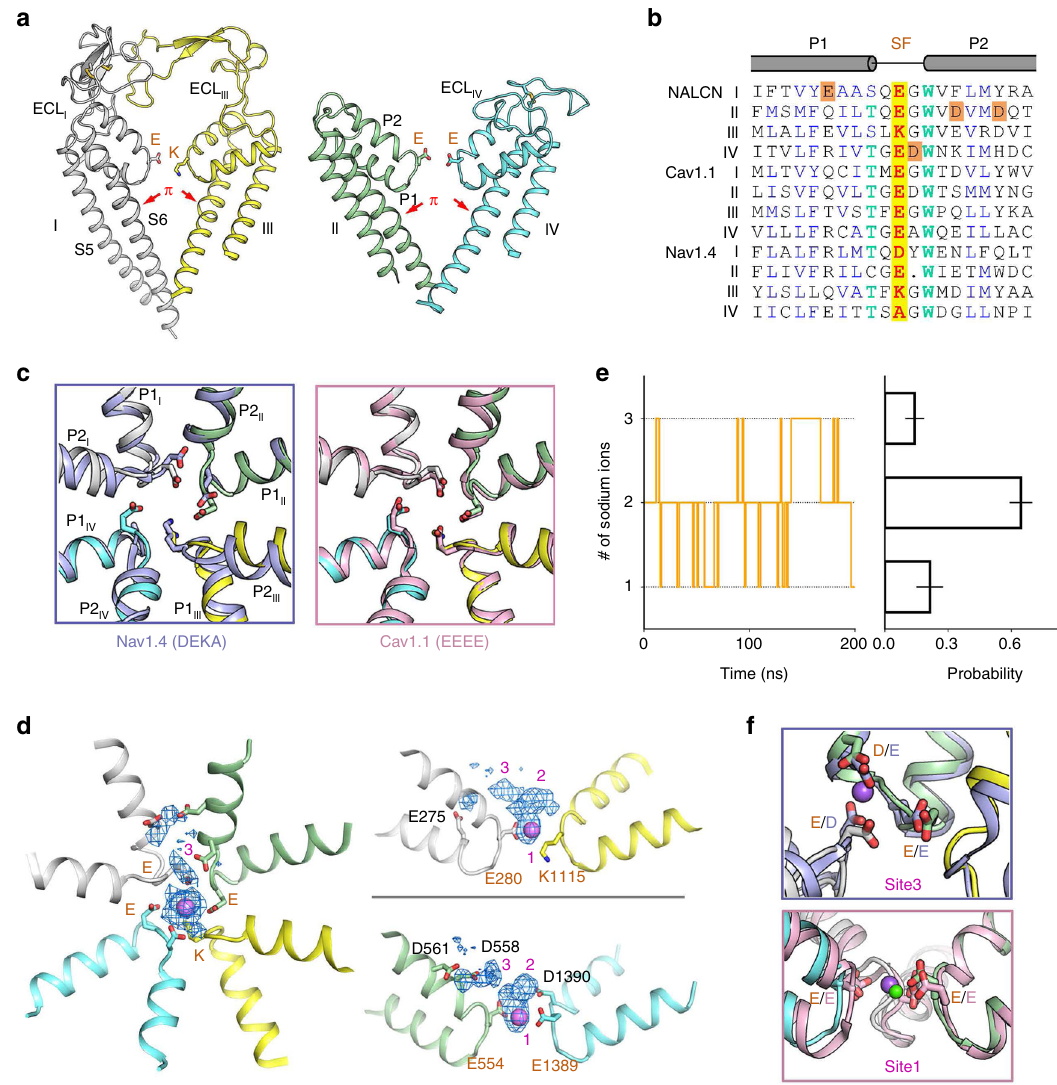
Fig. 5 The EEKE selectivity fi lter of NALCN. a Overall structure of the pore domain of NALCN. Side views of the pore domain from the diagonal repeats are shown. The EEKE residues in the selectivity fi lter (SF) are shown in stick. Repeat I and repeat III adopt large extracellular loops, reminiscent of Ca v 1.1. A π helix appears in each S6 segment and is indicated by red arrows. b Sequence alignment of the SF and the connecting pore helices among NALCN, Ca v 1.1, and Na v 1.4. The critical EEKE (E280, E554, K1115, and E1389) residues in NALCN and the corresponding residues in Ca v 1.1 (EEEE) and Na v 1.4 (DEKA) are shaded yellow. The invariant Trp residues and the highly conserved Thr residues are colored light green. The acidic residues that may help to coordinate cations in NALCN are shaded orange. c Structure comparisons of the SF between NALCN and Na v 1.4 ( left ) or Ca v 1.1 ( right ). The critical residues in the SF are shown in the stick. d Top view and two side views of sodium probability density generated from pore domain equilibration. Three potential Na + binding sites were identi fi ed and labeled in purple. The most stable binding site (Site1) is signposted by a Na + ion (magenta sphere). Please also refer to Supplementary Movie for the illustrative trajectory of equilibration. e Ion numbers within 4 Å of SF residues (EEKE) over time (left) and the probability statistics (right). The statistics represent the results of three independent simulations. f Structural comparison of Site 3 (EED motif) in NALCN and the Na + binding site (DEE motif) in Na v 1.4 (top) and of Site1 in NALCN and a Ca 2 + binding site in Ca v 1.1 (bottom). Na + and Ca 2 + are shown as purple and green spheres, (Fig. 5a). The key residues in the SF of NALCN responsible for voltage sensing gating in VGICs 45 , the relaxation to a fl exible the ion selectivity are E280/E554/K1115/E1389 (EEKE), distinct linker of S4-5 I may hinder the effective transduction of the from DEKA in Na v channels and EEEE/EEDD in Ca v channels. electromechanical coupling of repeat I in NALCN. Altogether, Sequence alignment of the P1-SF-P2 among NALCN, Ca v 1.1, and these structural variations in NALCN may contribute to its low Na v 1.4 reveals an invariant tryptophan in the fi rst residue of P2 voltage sensitivity. and a highly conserved residue (Thr/Ser/Cys) in the last residue of P1, while the other residues are not very conserved (Fig. 5b). The overall structure of P1-SF-P2 in NALCN is more closely EEKE selectivity fi lter in NALCN . Like all reported Na v /Ca v related to that of Ca v 1.1 than Na v 1.4, with r.m.s.d. values of 0.848 structures, the pore domain of NALCN is formed by the S5 and Å over 110 C α atoms and 1.602 Å over 107 C α atoms, respec- S6 helices of the four repeats, and the SF of NALCN is supported tively. The backbone of the pore helices of NALCN aligns well to by two-pore helices (P1 and P2) that intervene between S5 and S6